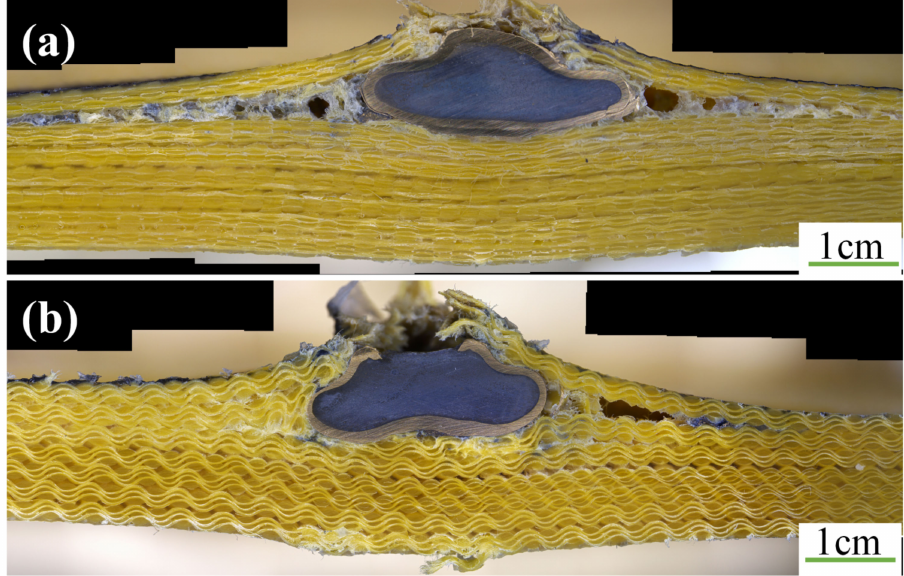
Figure 17. Cross-sectional views of the target plate failure morphology under Class I standard: ( a ) 33 picks/cm; ( b ) 36 picks/cm.